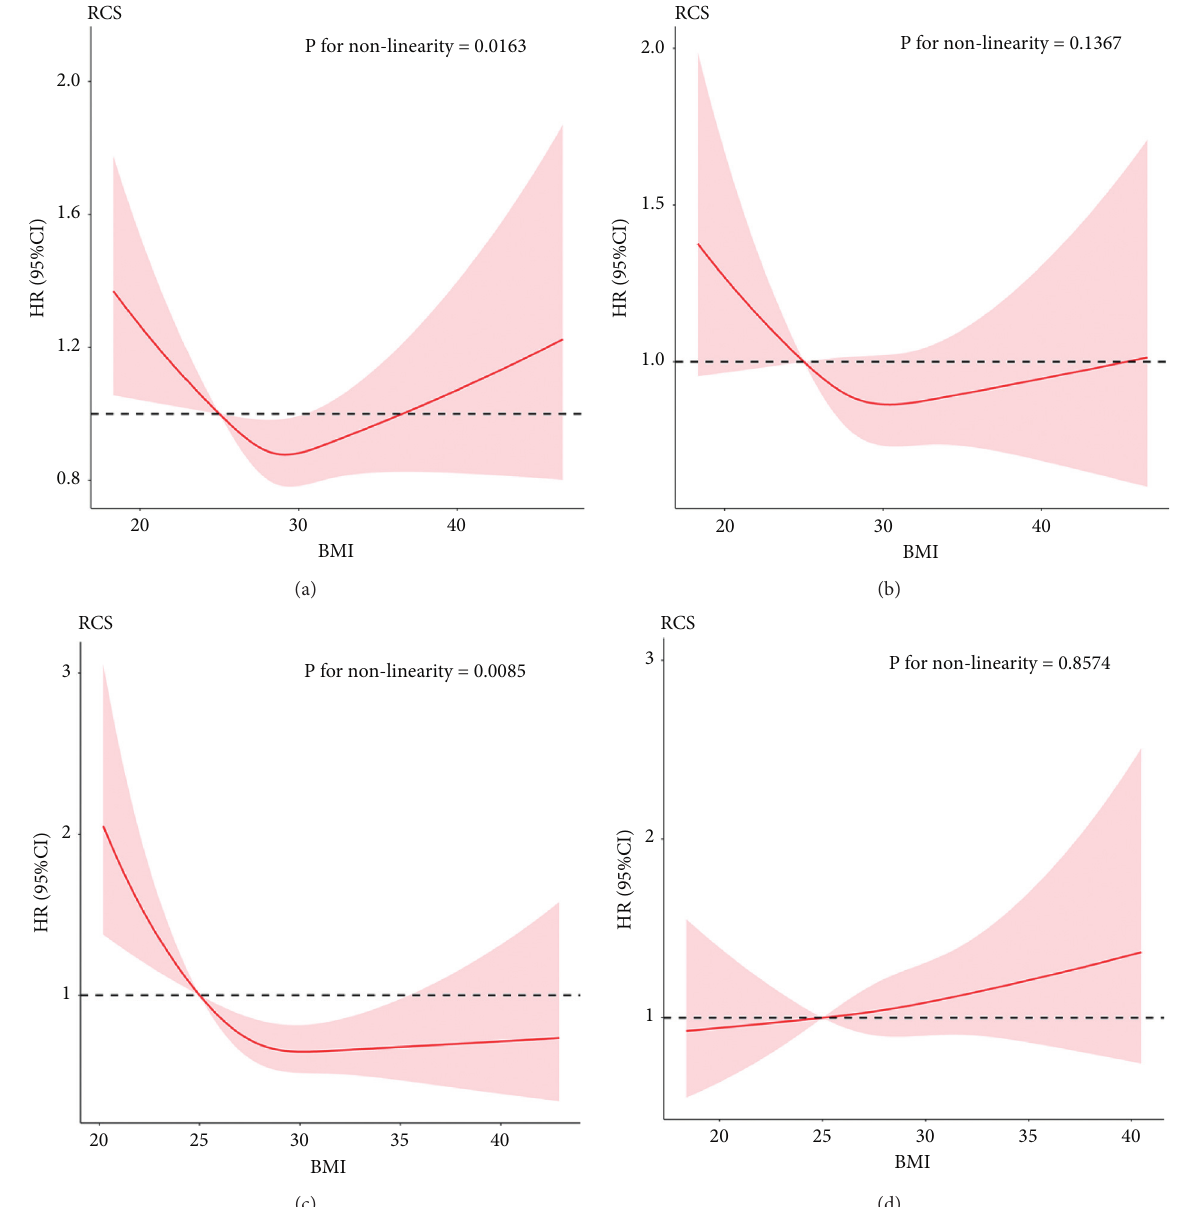
Figure 4: Dose-response curves for BMI and all-cause mortality of CABG patients by sex group with male (a) and female (b); dose-response curves for BMI and all-cause mortality of PCI patients by sex group with male (c) and female